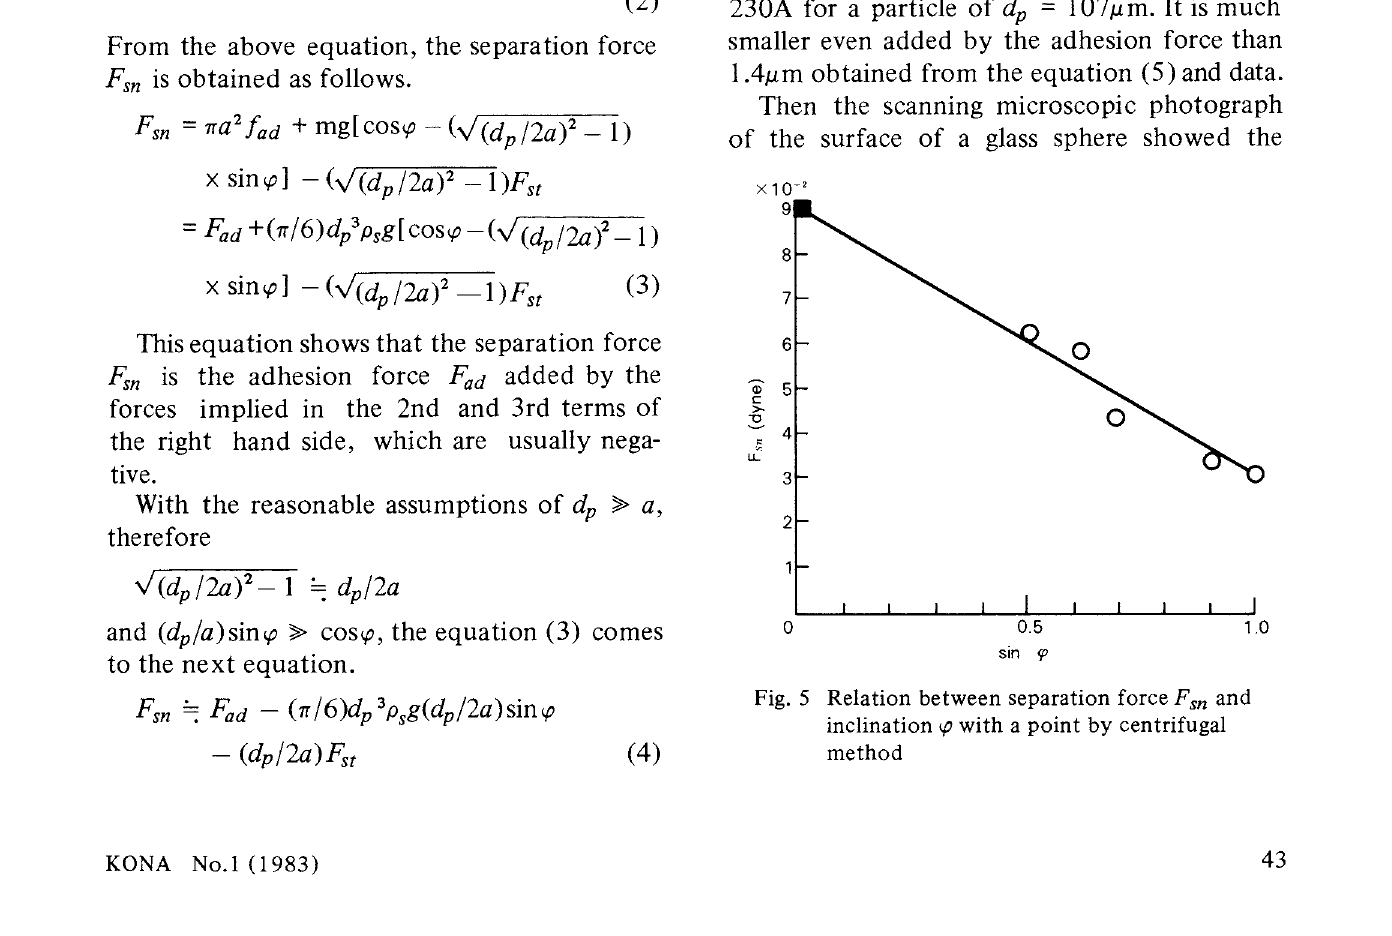
Fig. 4 The model of separation of a single particle from a plane surface.